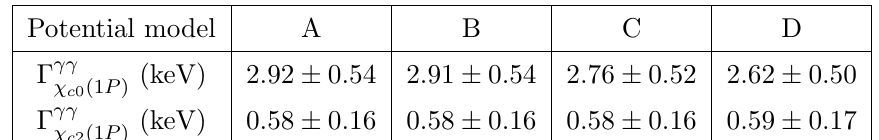
Table 6 . Results for the two photon decay widths of the states (cid:31) c 0 (1 P ) and (cid:31) c 2 (1 P ), indicated with (cid:0) (cid:13)(cid:13) and (cid:0) (cid:13)(cid:13) for short, for each of the potential models of section 4.1. (cid:31) c 0 (1 P ) (cid:31) c 2 (1 P ) Potential model